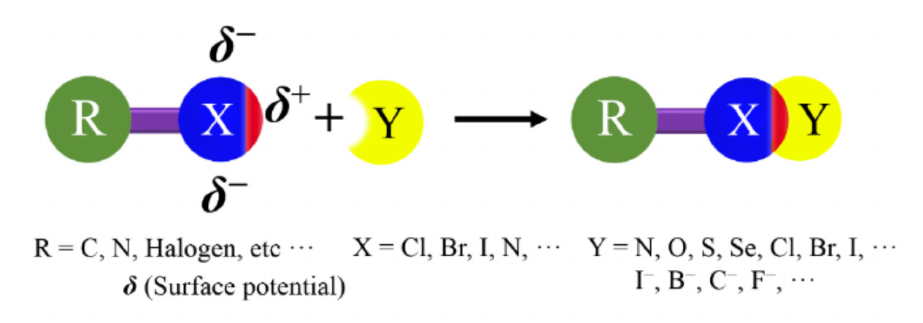
Figure 1. Structural scheme for a halogen bond